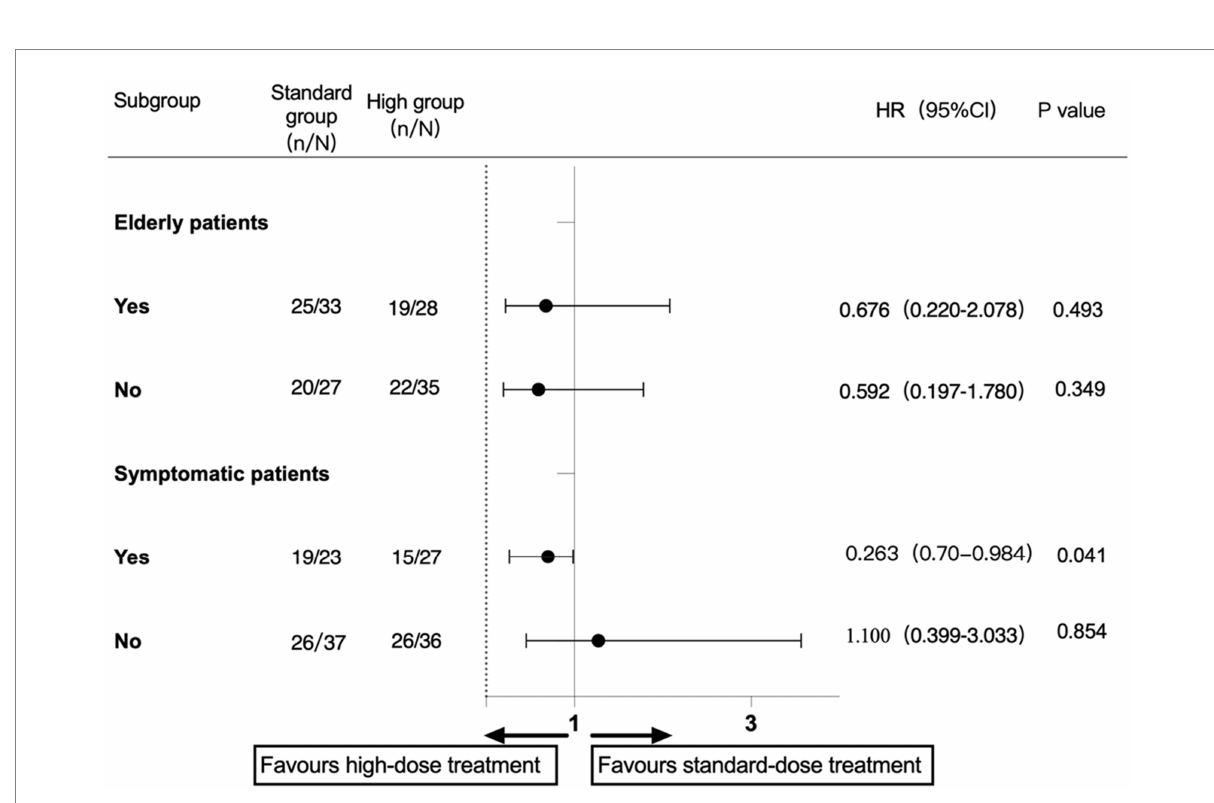
FIGURE 3 Subgroup analysis of the